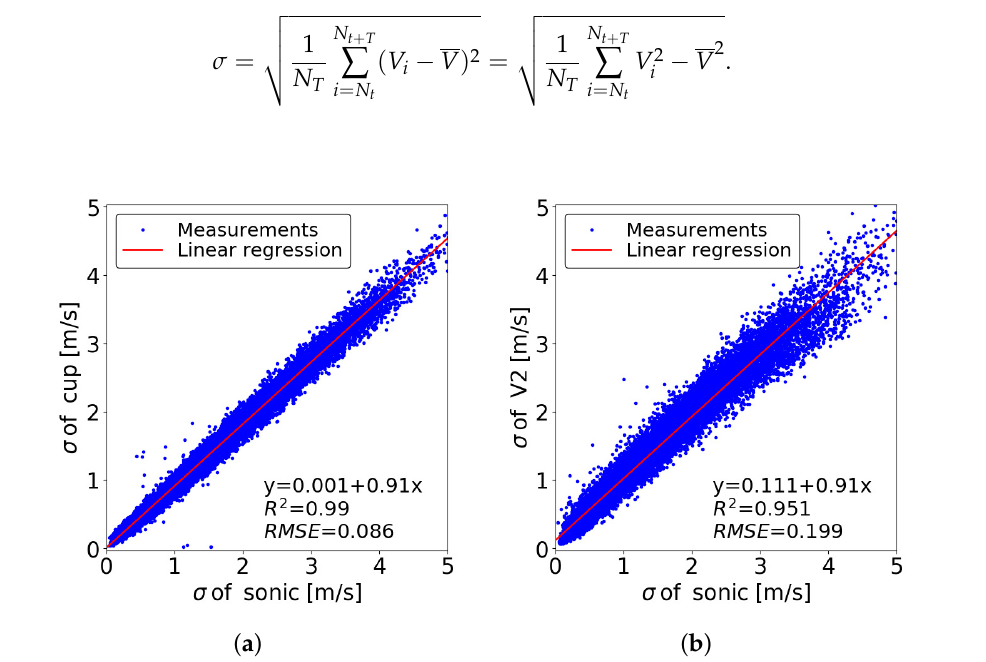
Figure 6. Comparison of standard deviation at 40 m height. ( a ) Sonic anemometer and cup anemometer; ( b ) Sonic anemometer and V2 profiling